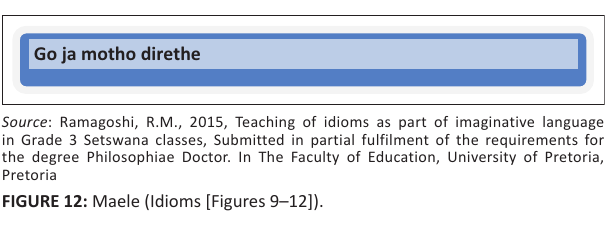
FIGURE 11: Maele (Idioms [Figures 9–12]).